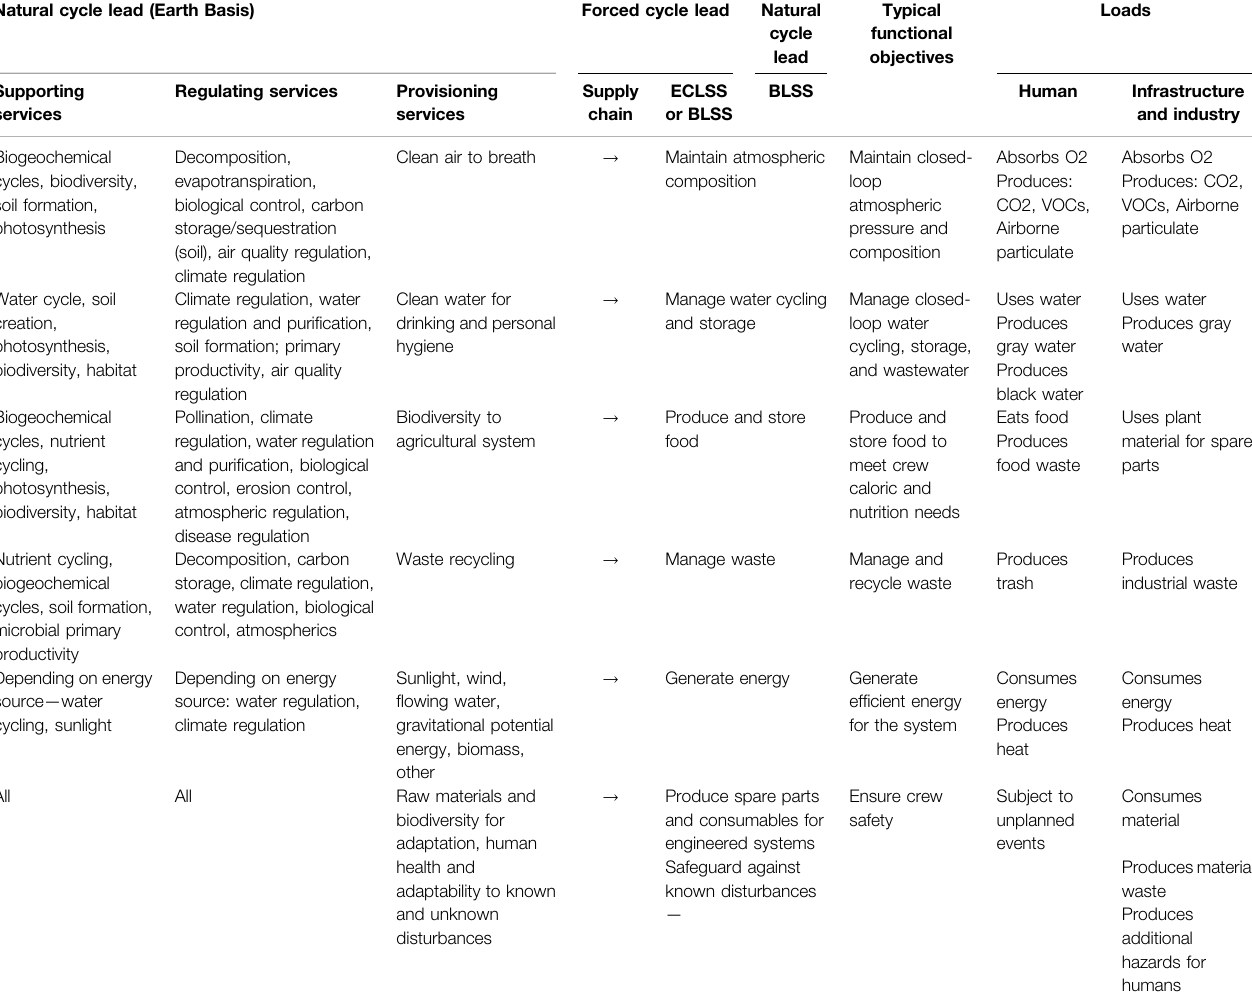
TABLE 1 | Life support system functional objectives in the context of natural and forced cycle lead services and human loads. Natural cycle lead (Earth